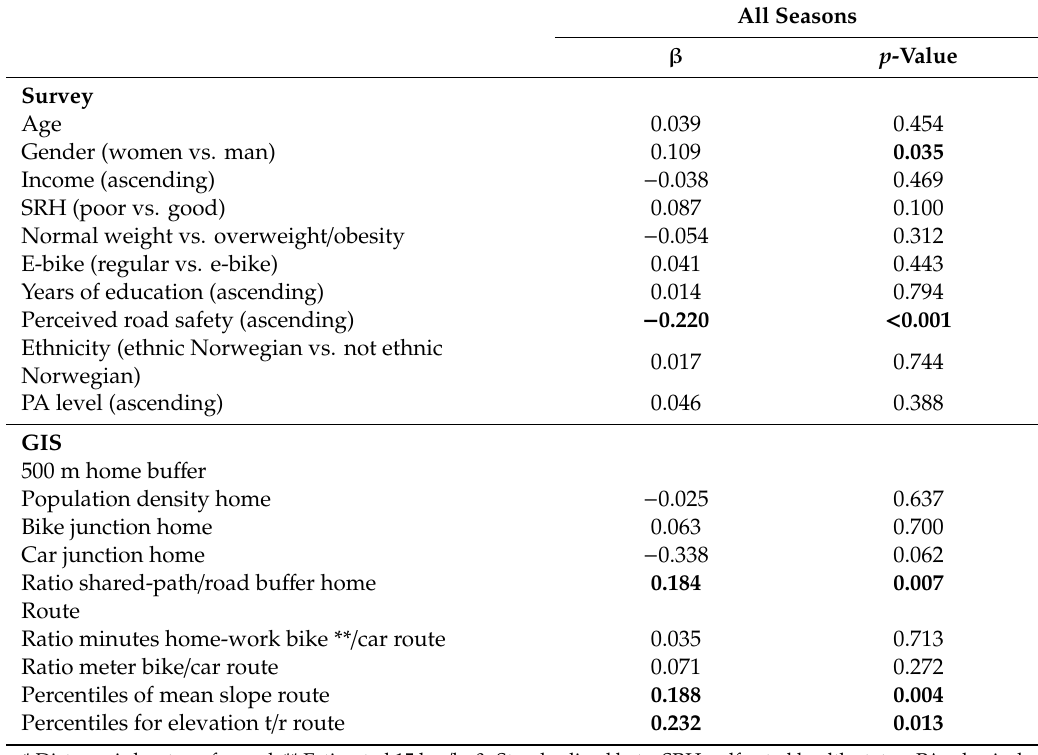
Table 4. Linear regression of distance * cycled. n = 307. Significant associations are written in bold.